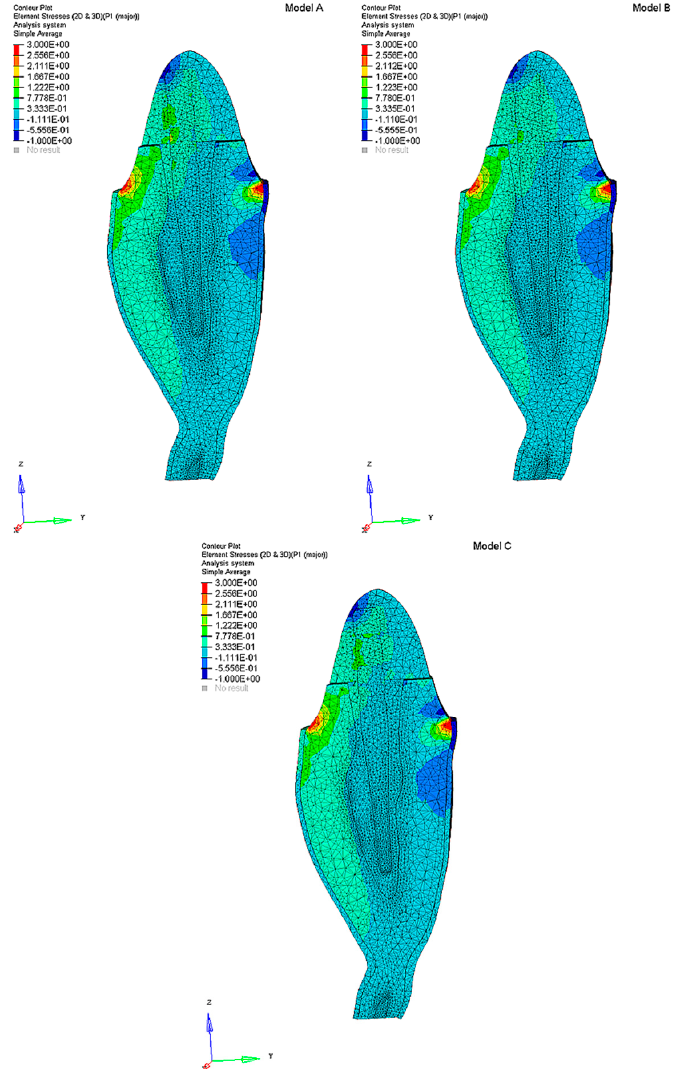
Figure 2. Models A , B, and C : maximum principal stress distribution (MPa) in the tooth restored with the three C-G/PEI posts with a ferrule: Model A (tooth with Post A —Young’s modulus of 57.7 GPa), Model B (tooth with Post B —Young’s modulus of 31.6 GPa), Model C (tooth with Post C —Young’s modulus decreasing from 57.7 to 9.0 GPa in the coronal–apical direction). The model components and their Young’s moduli and Poisson’s ratios are reported in Table 1.